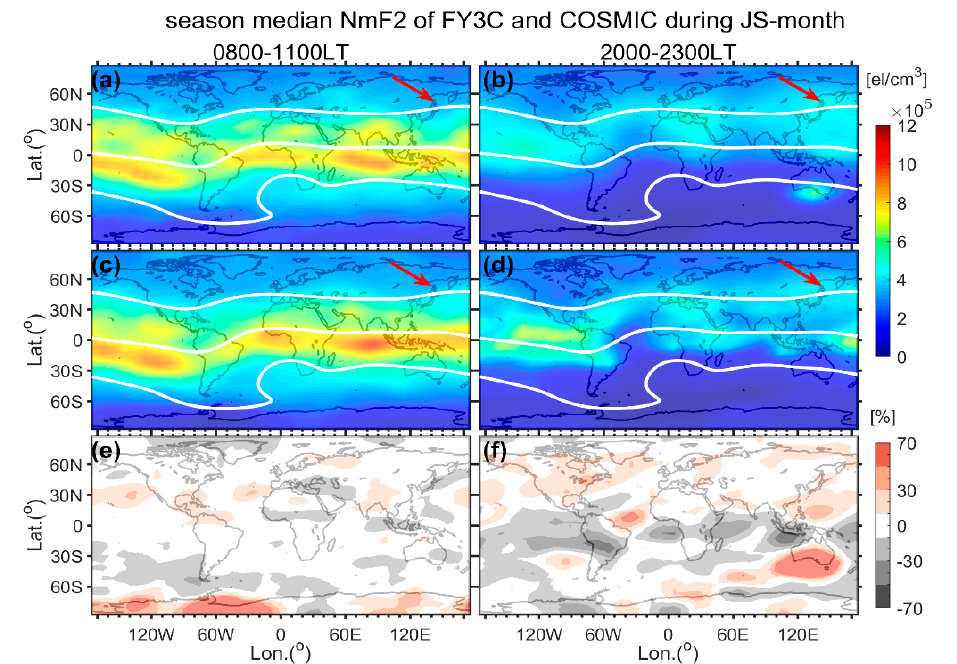
Figure 7. Ionospheric climatological characteristics of season median NmF2 observed by FY3C/GNOS and COSMIC and their differences at 0800–1100LT and 2000–2300LT during JS-month (±45 days to June solstice of 2016) from 2016.128 to 2016.218. The red arrow points to the diurnal variation of NmF2, in which the nighttime NmF2 enhancement, namely, the general Weddell Sea anomaly (WSA) can be clearly observed. Refer to Figure 6 for more detailed annotations.